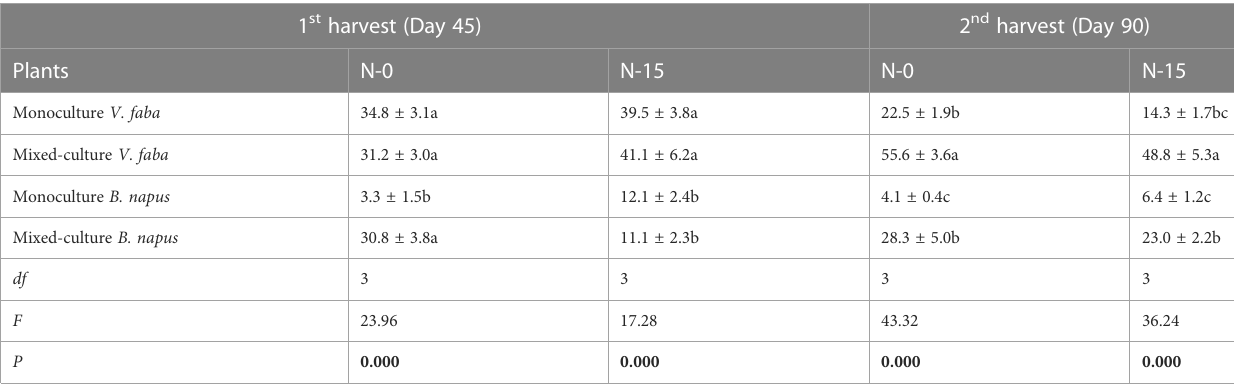
TABLE 1 Proportion of mycorrhizal colonization (mean ± SE) in monoculture and mixed-culture V. faba and B. napus under AMF inoculation and N- addition conditions of N-0 and